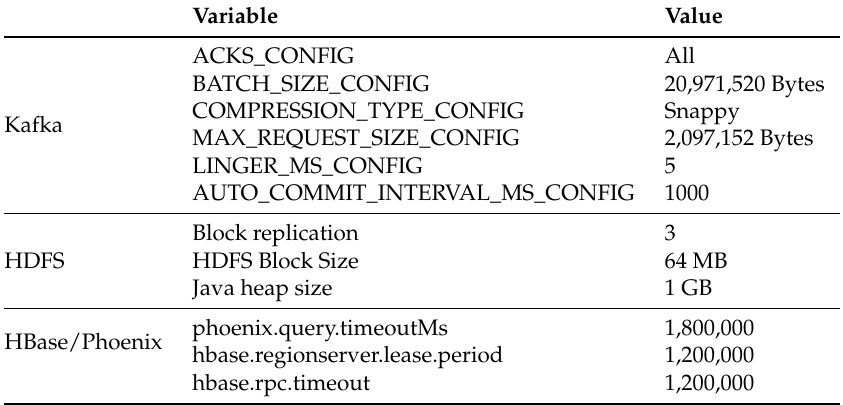
Table 2. Real-time video stream and acquisition component parameter